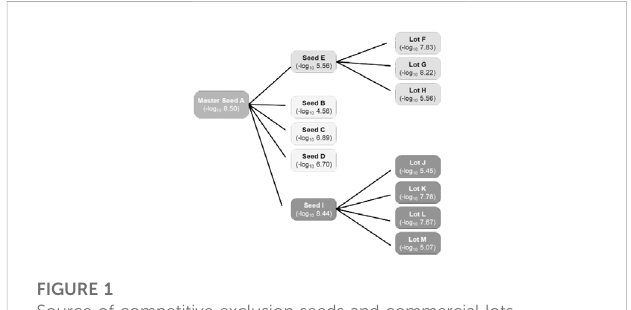
FIGURE 1 Source of competitive exclusion seeds and commercial lots. ( – log10: Reduction in Salmonella